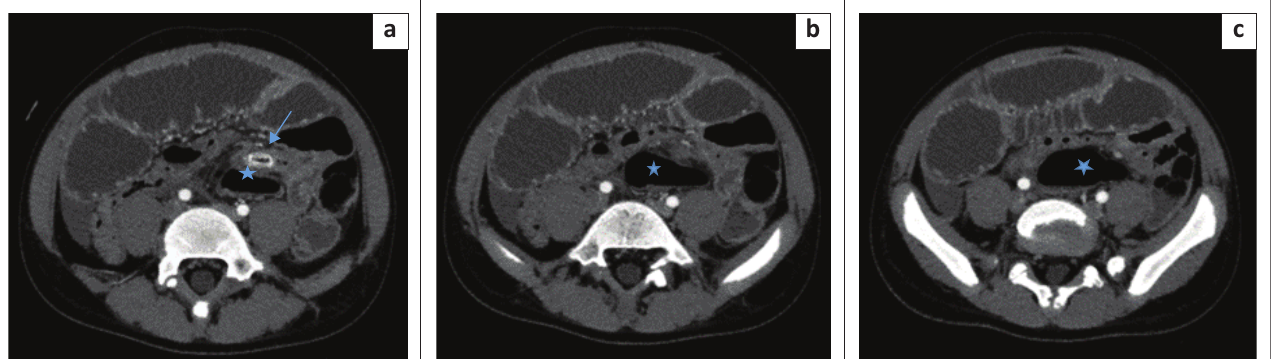
FIGURE 1: (a-c) (cephalad to caudad): A 12-year-old boy presented with abdominal distension, vomiting and a raised white cell count. Axial CT revealed the abnormal caecal position (blue star) in the left lower quadrant with an anterior cephalad thickened appendix containing an appendicolith (arrow) and adjacent fat stranding.